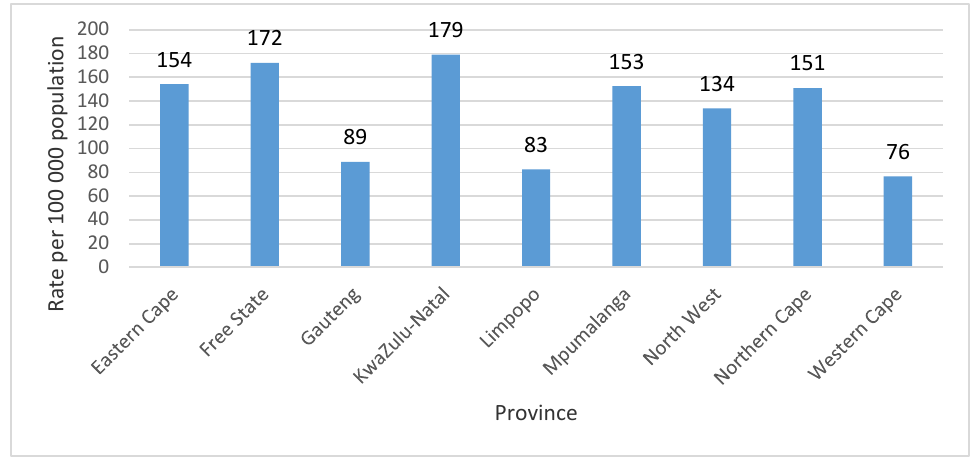
Africa, 2005-2015